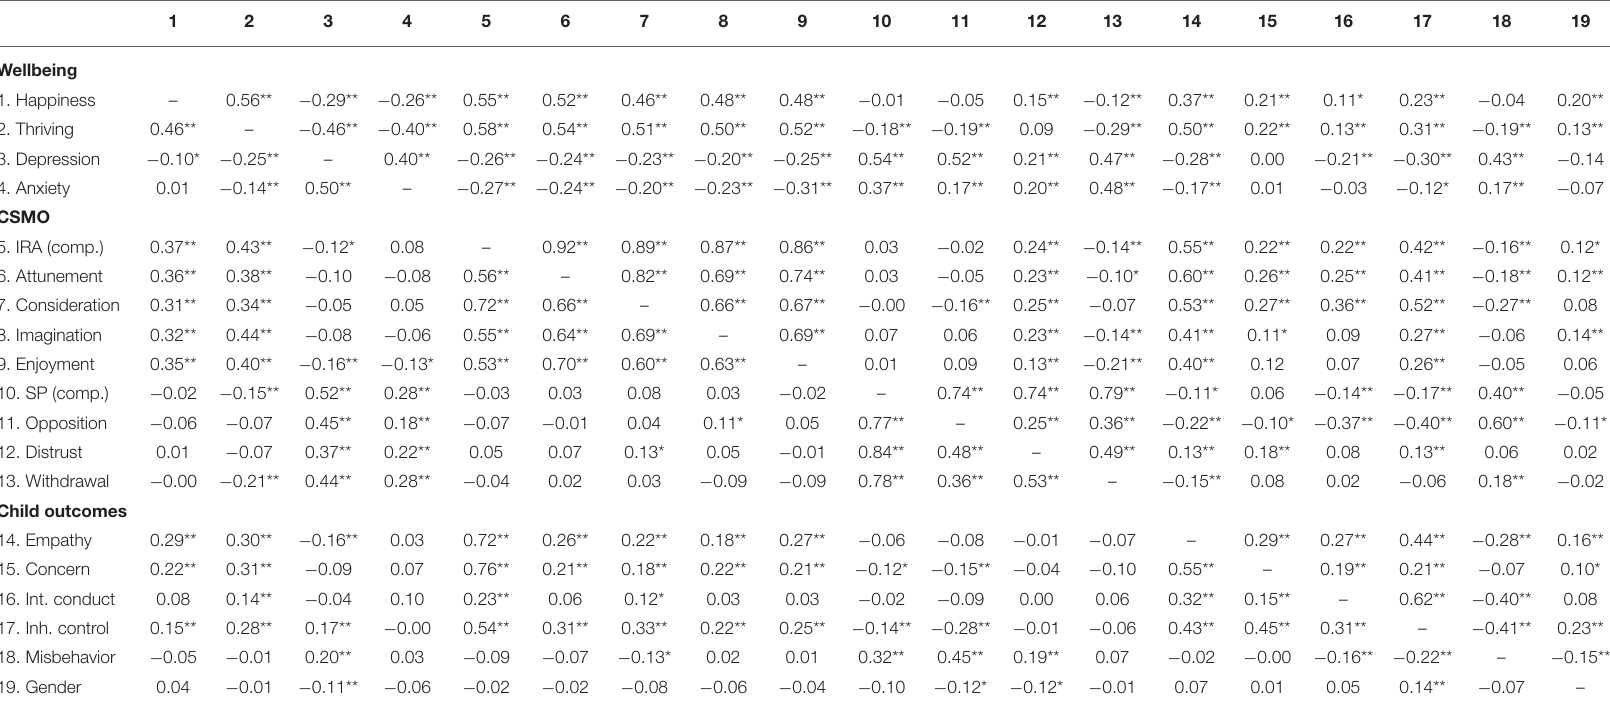
TABLE 3 | Within country pearson’s correlations of all variables for Study 1 (USA) and Study 2